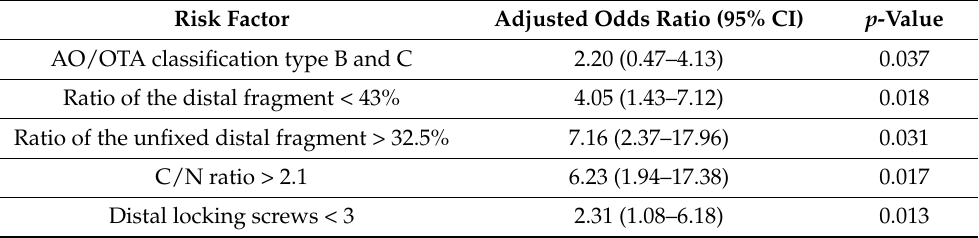
Table 2. Risk factors for non-union after antegrade nailing (univariate analysis). Risk Factor Odds Ratio (95% CI) p -Value AO/OTA classification type B and C Ratio of the distal fragment < 43% 0.002 Ratio of the unfixed distal fragment > 32.5%